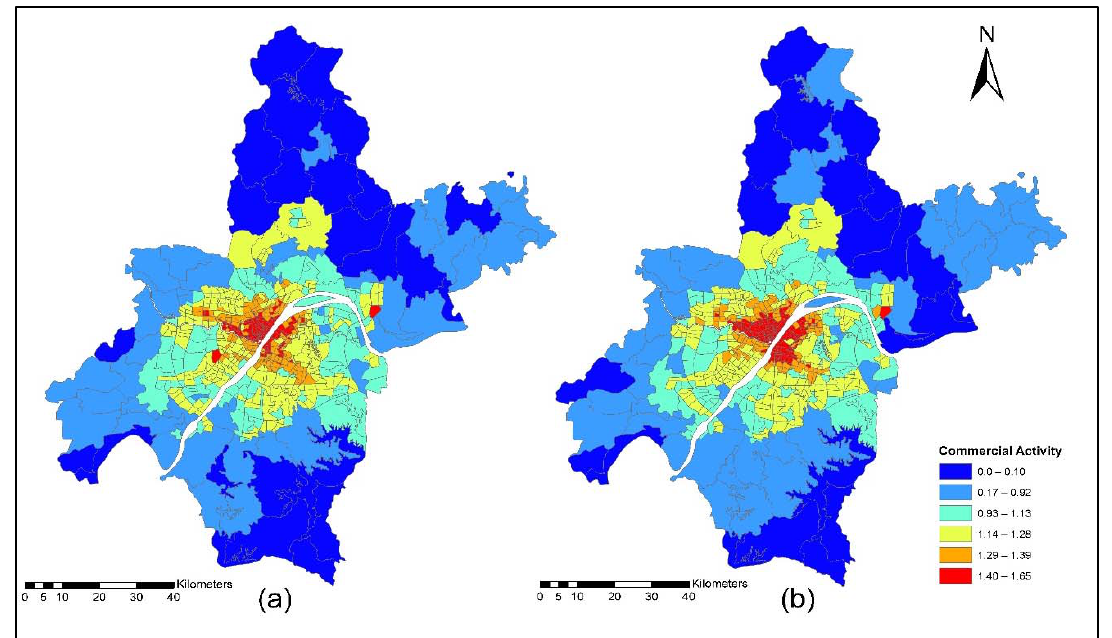
Figure 17. ( a , b ) Accessibility of commercial activities: ( a ) during off-peak for the year 2012; ( b ) dur- ing off-peak for the year 2015. off-peak for the year